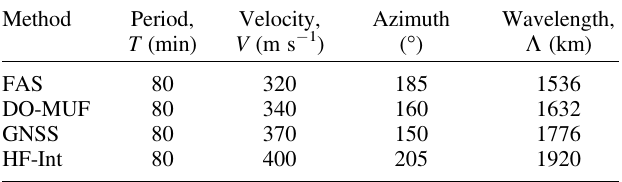
T = 80 min and V = 400 m s (cid:1) 1 , and the South African network observes a disturbance with T = 120 min and V = 500 m s (cid:1) 1 .